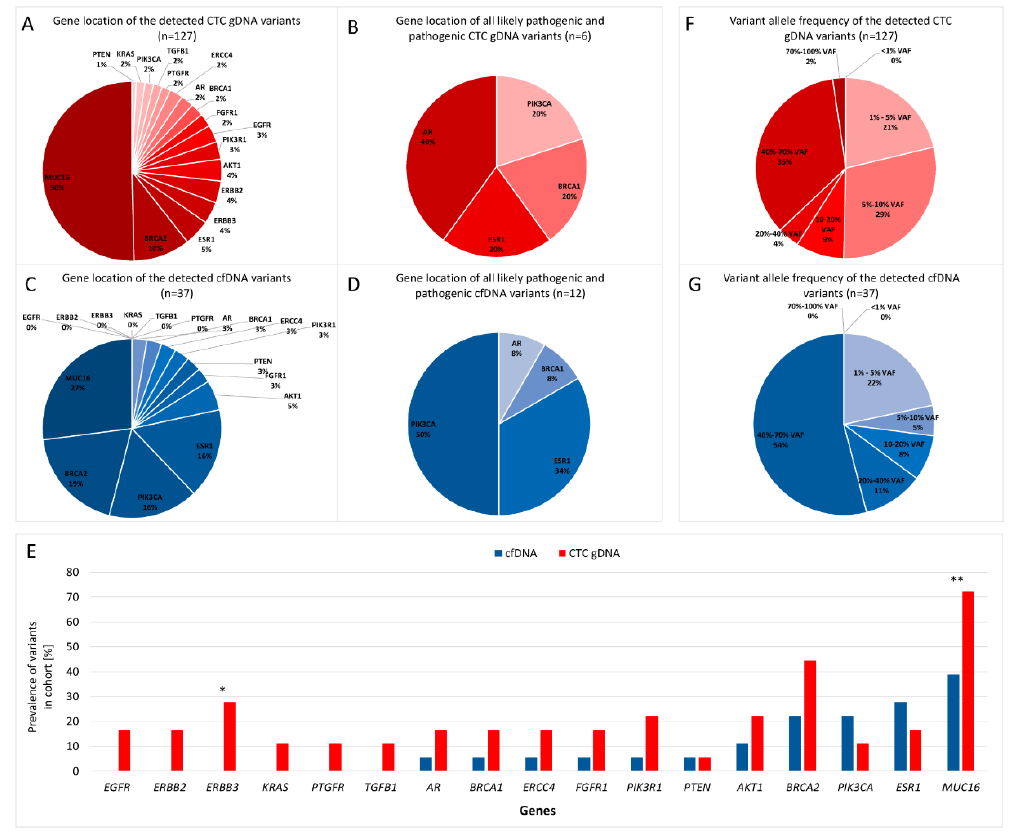
Figure 2. Distribution of the detected variants across the sequenced genes and their allele frequencies.